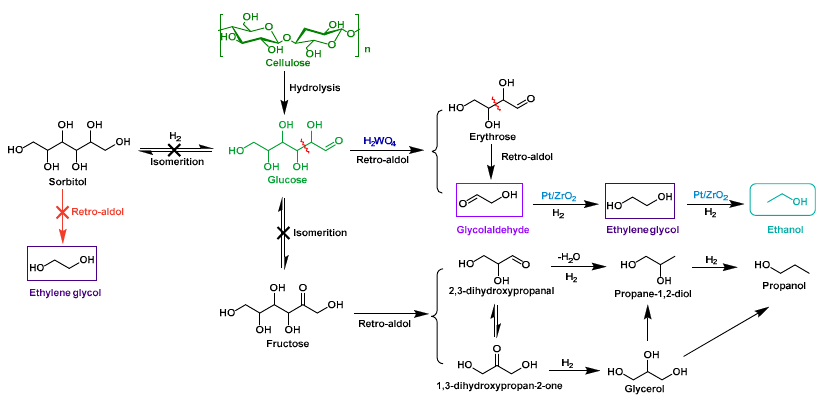
Figure 4. The proposed mechanism for conversion of cellulose into ethanol in one pot with H 2 WO 4 -Pt/ZrO 2 as a catalyst.